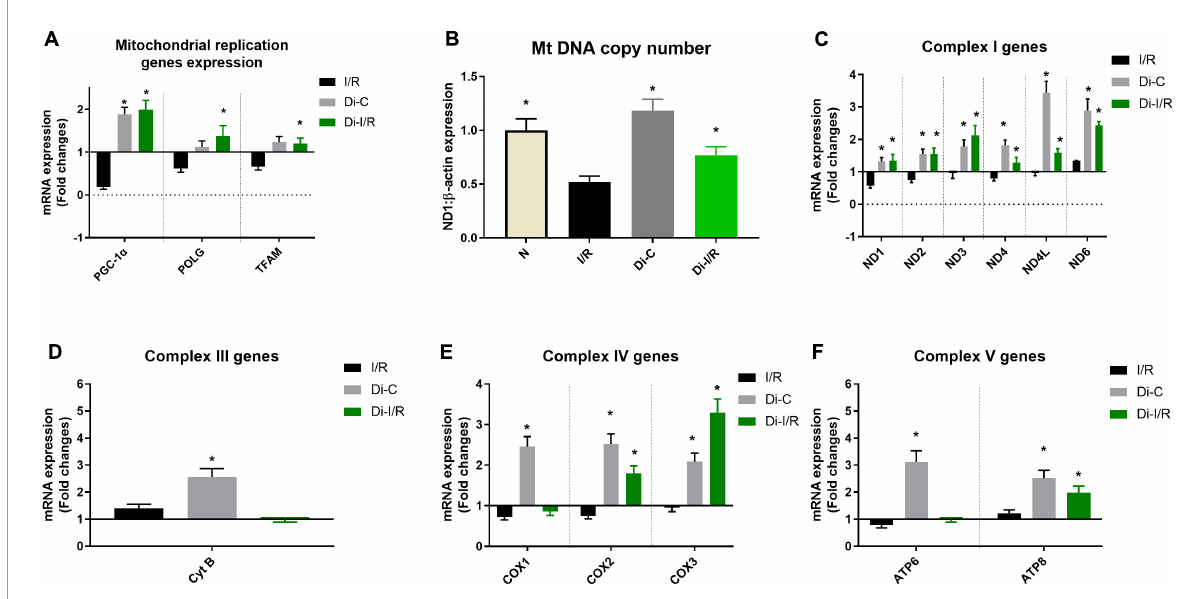
FIGURE6 DNA methyltransferase (DNMT) inhibitor pre-treatment upregulated the mitochondrial replication and mitochondrial encoded ETC genes and improved the mitochondrial copy number during I/R. (A) The mRNA expression changes of replication control genes; Panel (B) represents the mitochondrial DNA copy number; The mRNA expression changes of mitochondrial encoded ETC genes were presented for (C) Complex I; (D) Complex III; (E) Complex IV; (F) Complex V. The graph represents the mean ± SD. The changes in gene expression are represented as fold changes from the normal group. * p < 0.05 vs. I/R.